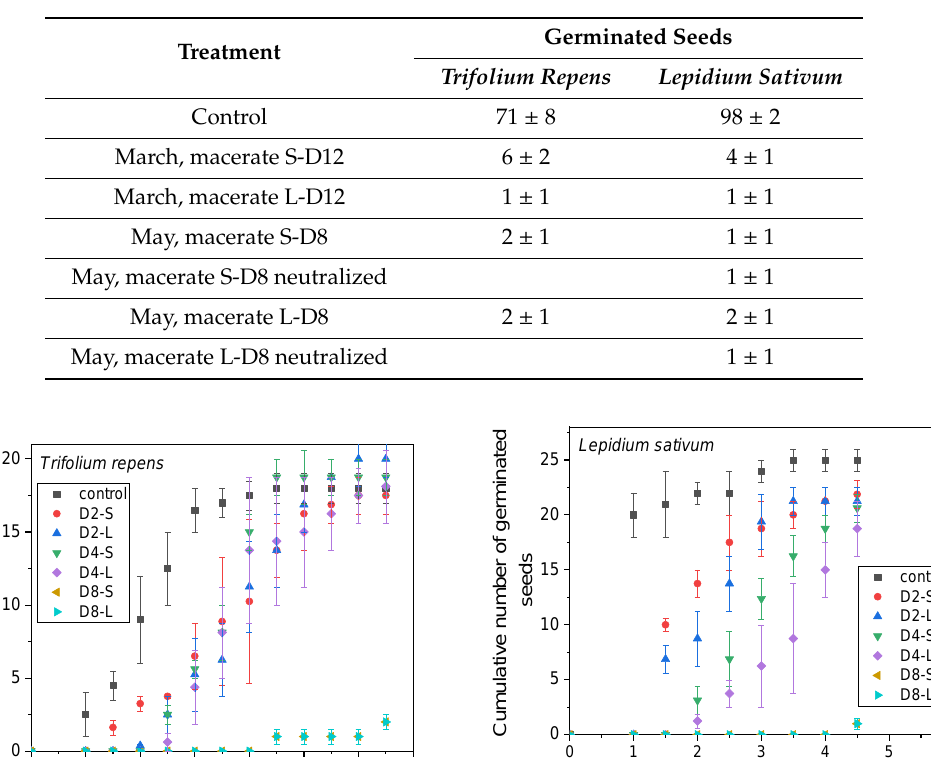
Table 1. Number of germinated seeds for di ff erent treatments at 7 days post imbibition.